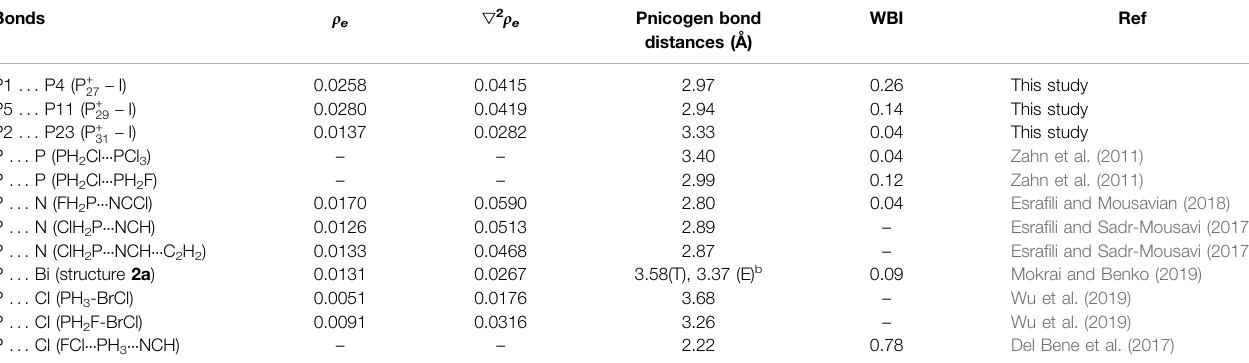
TABLE1| Electrondensities( ρ e ,a.u.),Laplacianoftheelectrondensities( ▽ 2 ρ e ,a.u.),Pnicogenbonddistances(Å),andWibergBondIndexes(WBI)ofthepnicogenbondsin P + 27 − I , P + 29 − IandP + 31 − I, compared with those of some pnicogen bonds previously reported. a